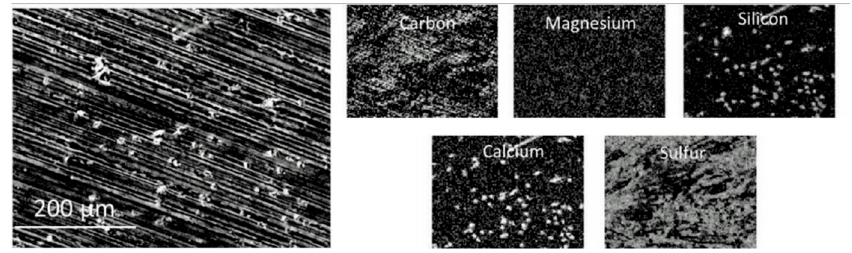
Figure 6. SEM-EDS results that show the presence of elements such as carbon, magnesium, silicon, calcium, and sulfur in the as-received sample.